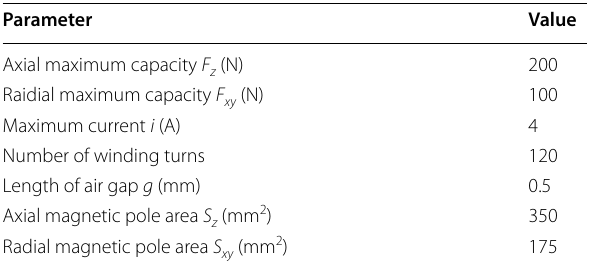
Table 1 Specification of a prototype